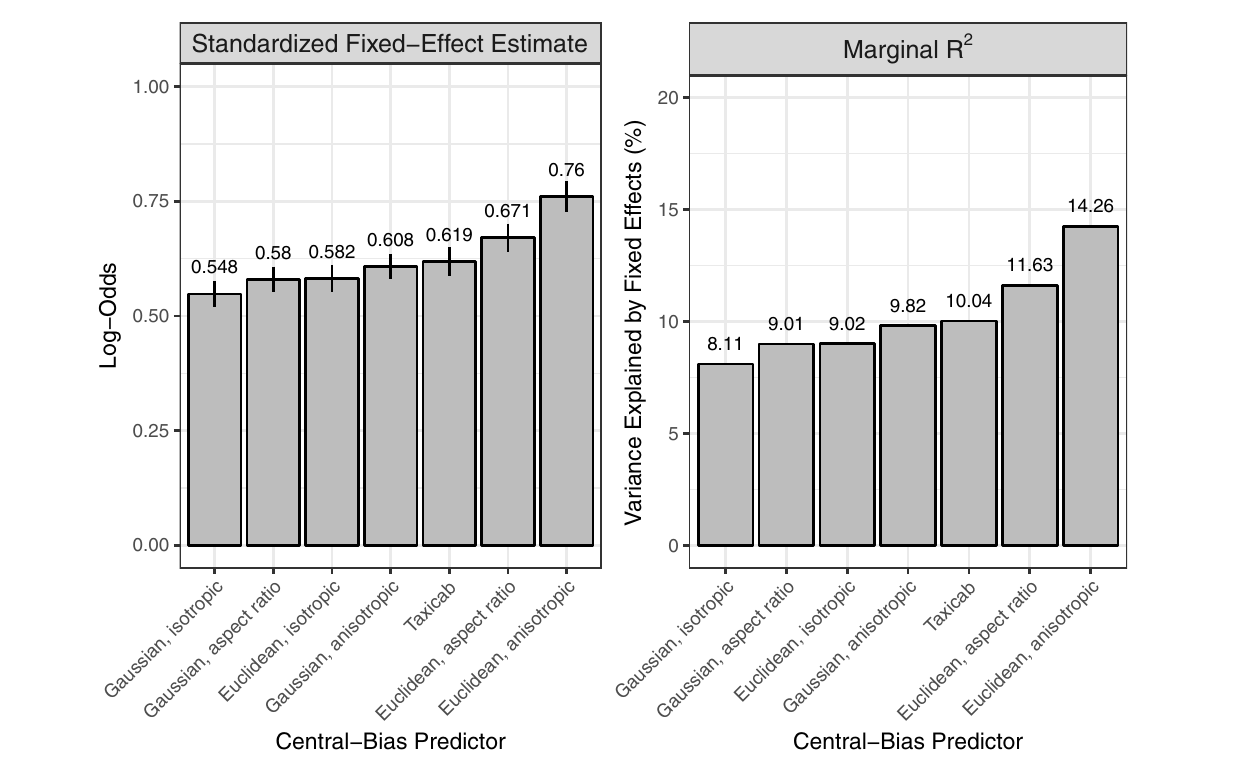
FIGURE 4 | One-predictor GLMMs, each testing a dedicated central-bias variable. Two measures were used to rank seven central-bias variables: the standardized regression coefficient for the fixed effect central bias (left) and the marginal R 2 (right) . For visualization purposes, the negative regression coefficients from the GLMMs are presented as absolute values.